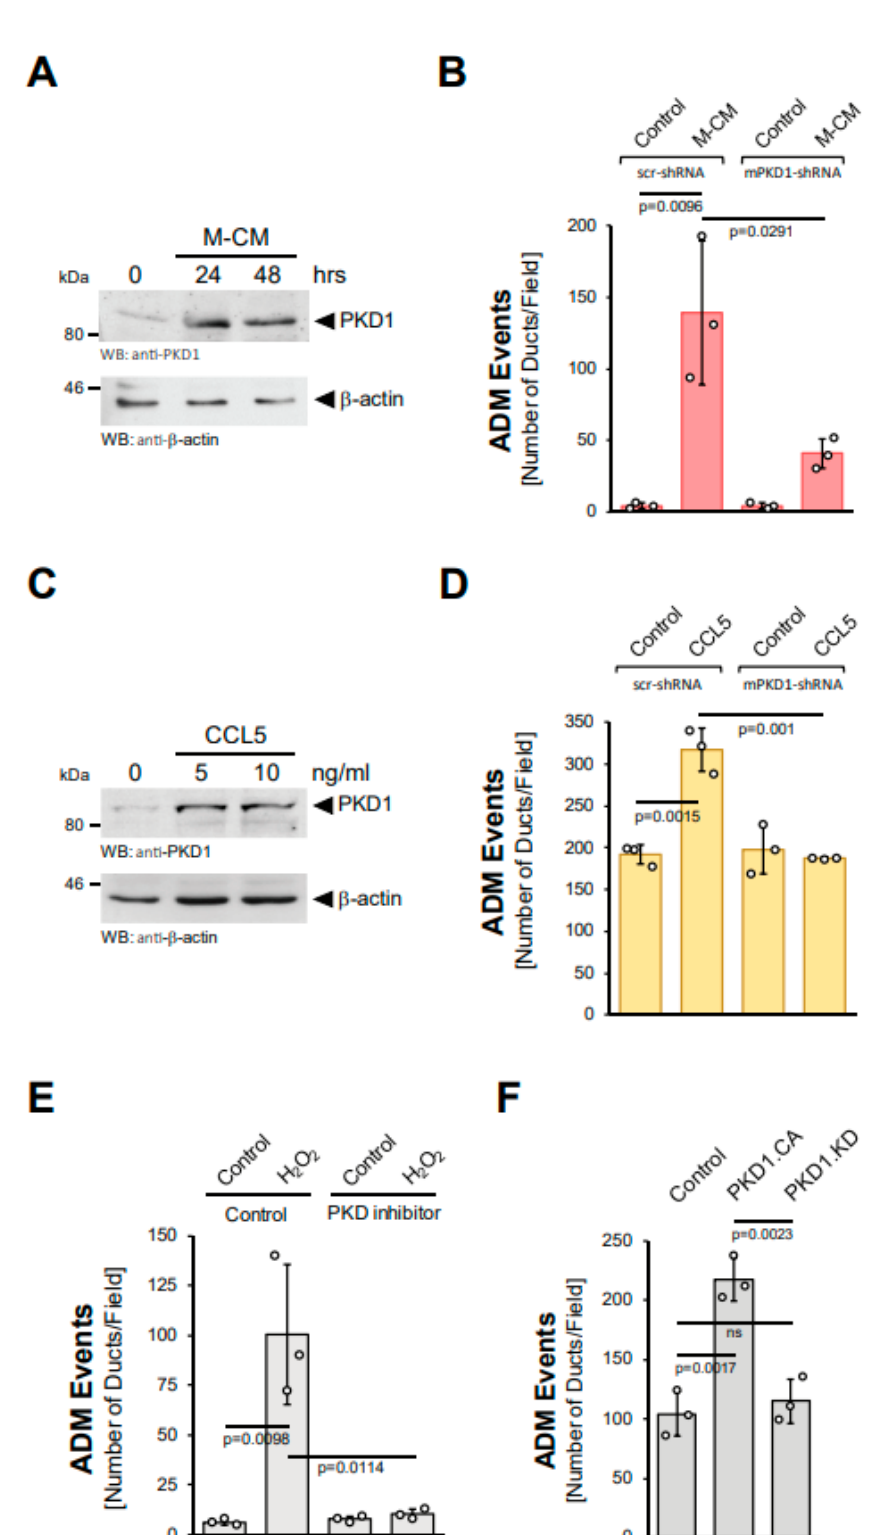
Figure 4. Protein Kinase D1 is downstream of different inducers of ADM. ( A ): Mouse pancreatic acinar cells were isolated and stimulated with M-CM for the indicated time. Cells were lysed and analyzed by Western blot for expression of PKD1 or for β -actin (control for equal loading). ( B ): Mouse pancreatic acinar cells were isolated, lentivirally-infected with control (scr-shRNA) or mPKD1-shRNA and seeded in 3D collagen culture. As indicated, ADM was induced by replacing the overlaying media with macrophage media (control) or macrophage-conditioned media (M-CM). Ducts